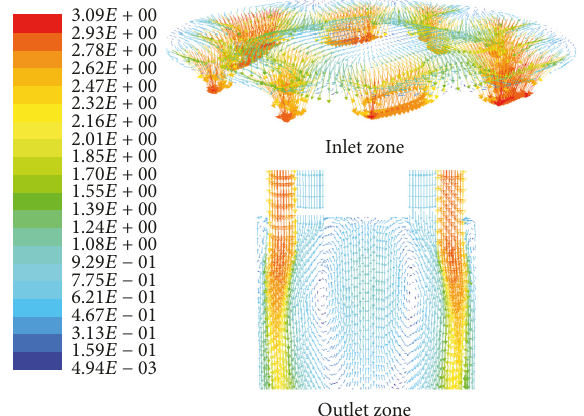
Figure 12: Flow fields at the core entrance and outlet for an inlet mass flow rate of 300 kg/s.